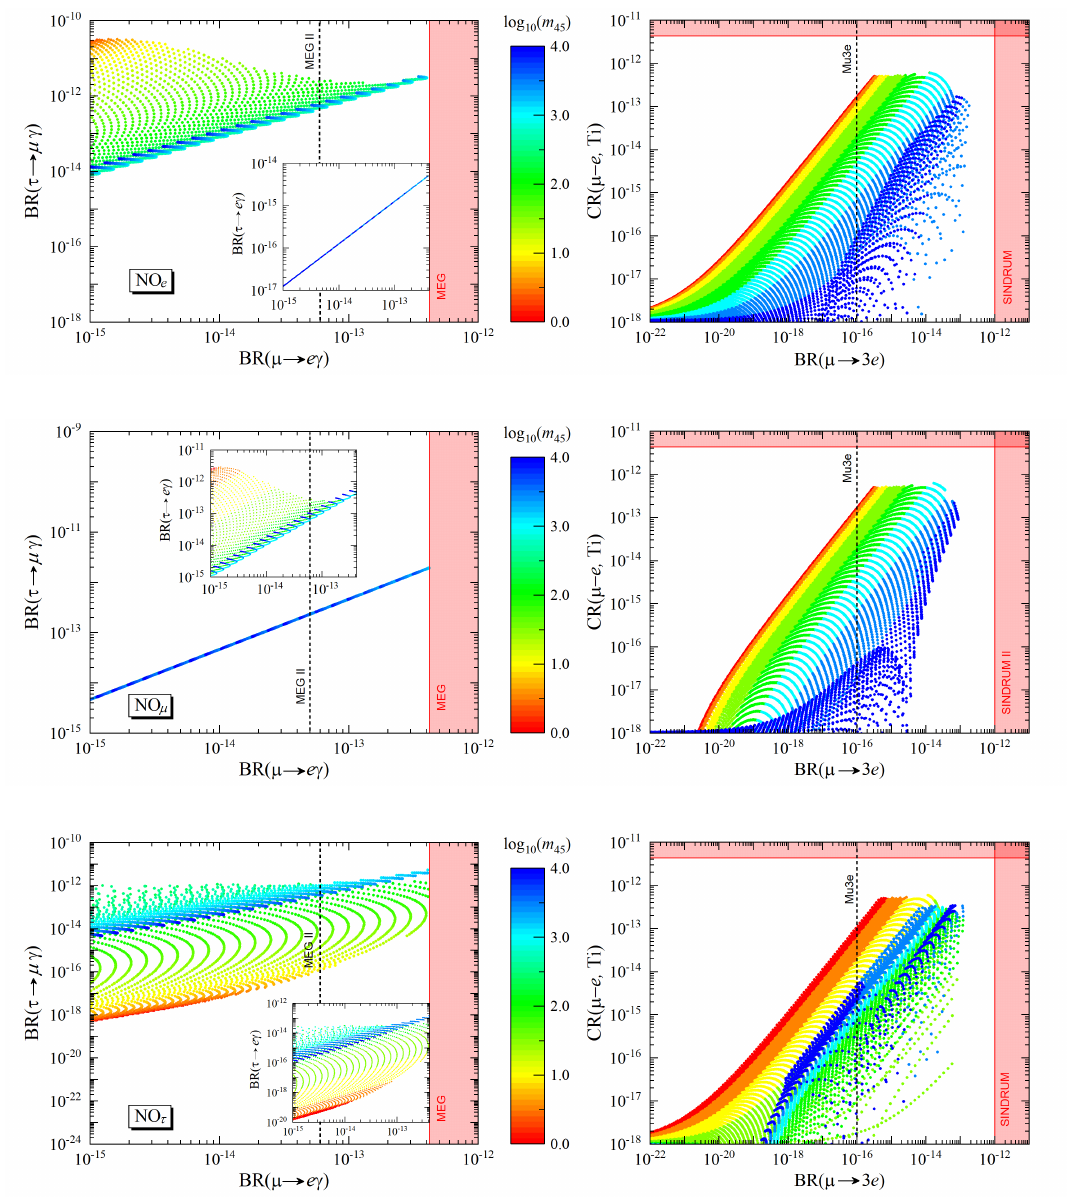
Figure 6 . (Left) BR( τ → µγ ) and BR( τ → eγ ) (inner plots) vs. BR( µ → eγ ) for NO e,µ,τ from top to bottom. The MEG bound BR( τ → eγ ) < 4 . 2 × 10 − 13 sets the vertical red exclusion band, while the vertical dashed line corresponds to the MEG II projected sensitivity. (Right) CR( µ − e, Ti) vs. BR( µ → 3 e ) for the same NO case as in the left panel. The vertical and horizontal red exclusion bands result from the SINDRUM and SINDRUM II limits on BR( µ → 3 e ) and CR( µ − e, Ti) , respectively (see table 8). The vertical dashed line corresponds to the Mu3e projected sensitivity for µ → 3 e . In all panels, the scatter points obey all constraints shown in table 8, being their colour linked to the value of m according to the colourmap shown in the 45